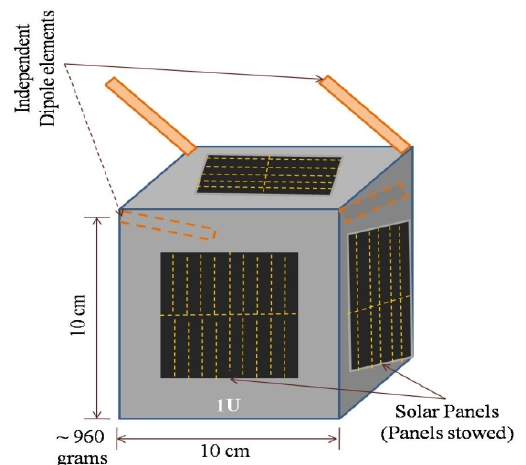
Figure A1. 3D model of MaSat 1: CubeSat of Sidi Mohamed Ben Abdellah University, city of Fez, Morocco [6].